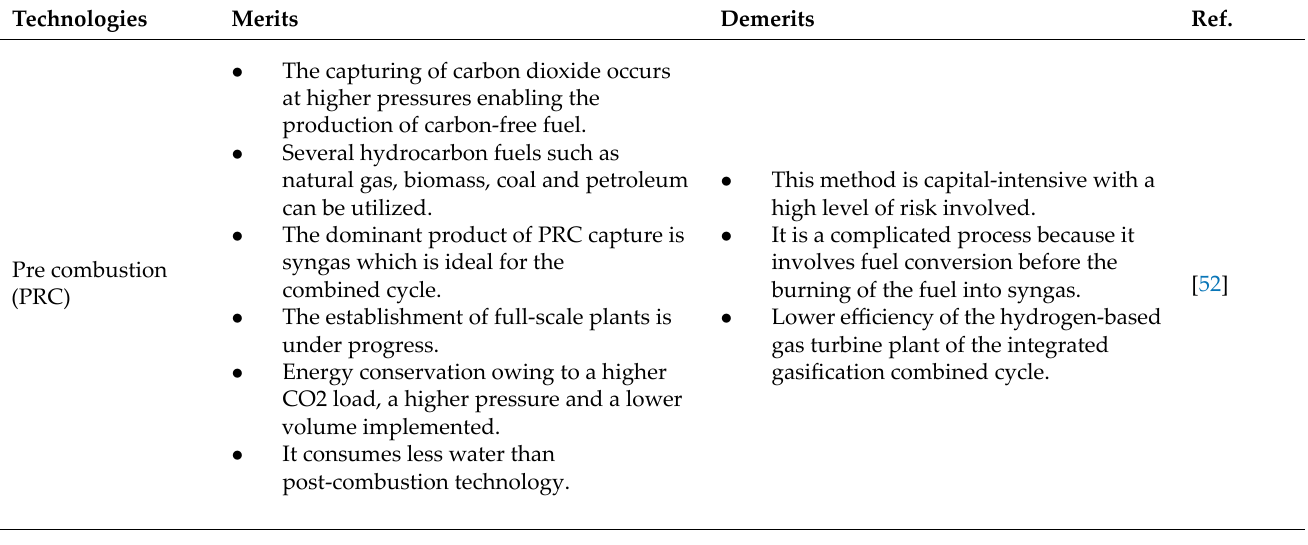
Table 1. Comparison of various CO 2 capture approaches in terms of merits as well as demerits. Technologies Merits Demerits